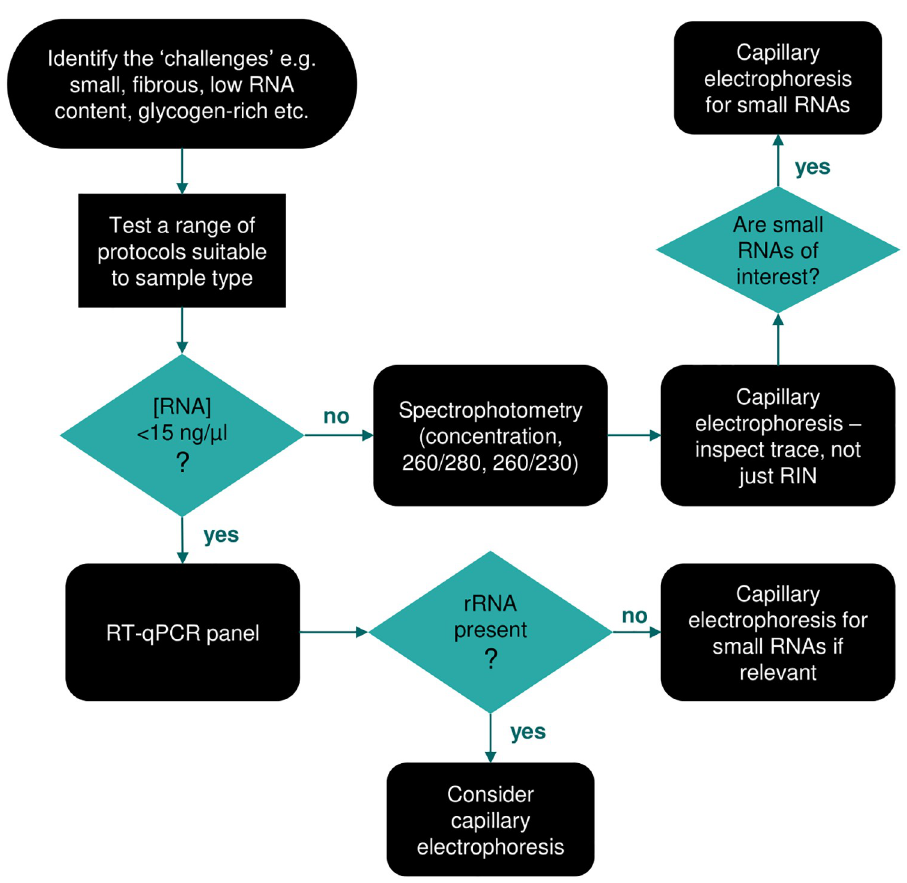
Fig 5. Decision tree for optimising appropriate protocols for RNA extraction from challenging